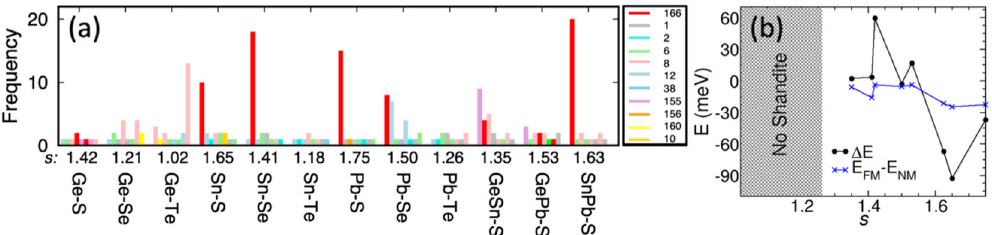
Fig. 2 Stable con fi gurations of Co-based compounds. a The low-energy structures for Co-based materials (Co-M-X or Co-MM ’ -X), where the crystal structures are color coded and arranged by the energy hierarchy for a given composition, i.e., the one listed fi rst is the most stable con fi guration. The red bars represent the shandite structure (No. 166). The vertical axis represents the emergent frequency of different structures from the PSO simulation. We introduced a structure tolerance factor ( s ), s = r (M)/ r (X) as a structure descriptor for shandite, where r (M) and r (X) indicate the radius of a metal and a chalcogen, respectively, and the average atomic radius of two metal atoms is taken as r (M) for metal alloys. The s values of each compound are listed. b The energy differences ( Δ E ) between the shandites and the ground-state structures and the energy difference between FM and nonmagnetic states ( E FM − E NM ) for the given compounds are plotted in term s of s in black and blue lines, respectively. If the shandite structure is the ground-state structure, Δ E and E FM − E NM calculate the energy difference to the second stable structure.